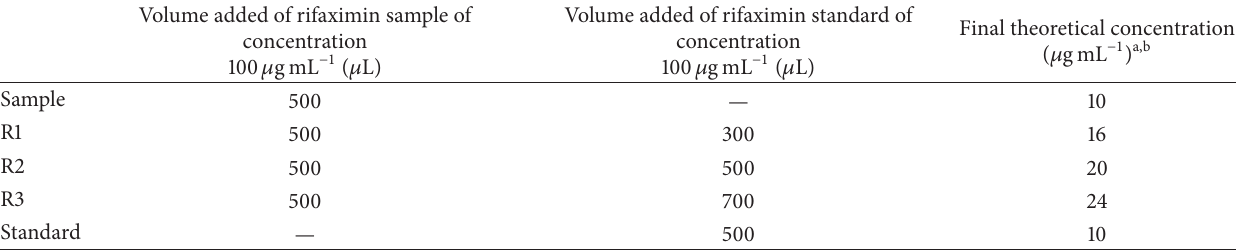
Table 1: Preparation of the solutions to the accuracy test of the spectrophotometric method in the UV